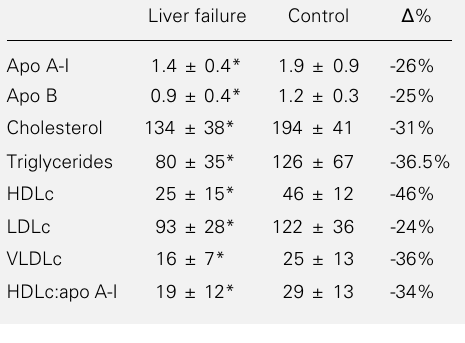
Table 2 - Plasma apolipoproteins (g/l) and lipids (mg/ dl) of patients with chronic liver failure (N = 74) com- pared with control subjects (N = 82).